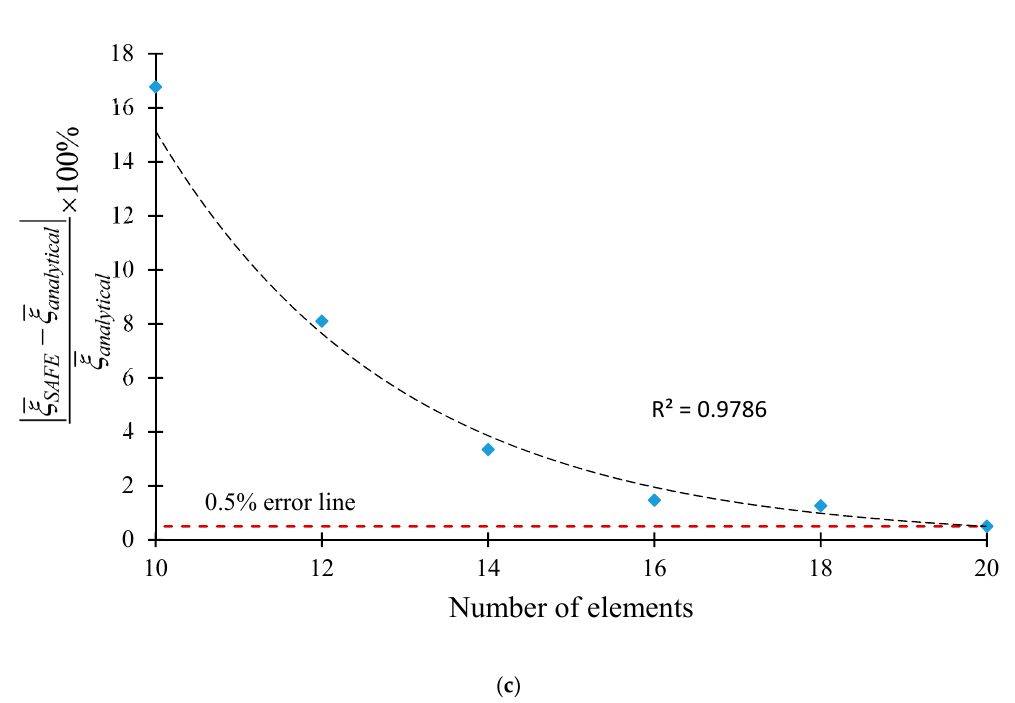
Figure 9. Convergence of the SAFE method in a 1-mm isotropic aluminum alloy plate showing that 0.5% accuracy in the highest wavenumber-frequency pair can be obtained with N = 20 SAFE elements across the thickness. The SAFE plots are overlapped on top of the exact analytical plots: ( a ) for N = 8, divergence from exact analytical solution at the upper left corner of the wavenumber-frequency diagram; ( b ) for N = 20, the SAFE and analytical solutions overlap everywhere; ( c ) convergence plot showing the error falling below 0.5% as N increases from N = 18 to N = 20. The trend line is a high-R exponential fit.